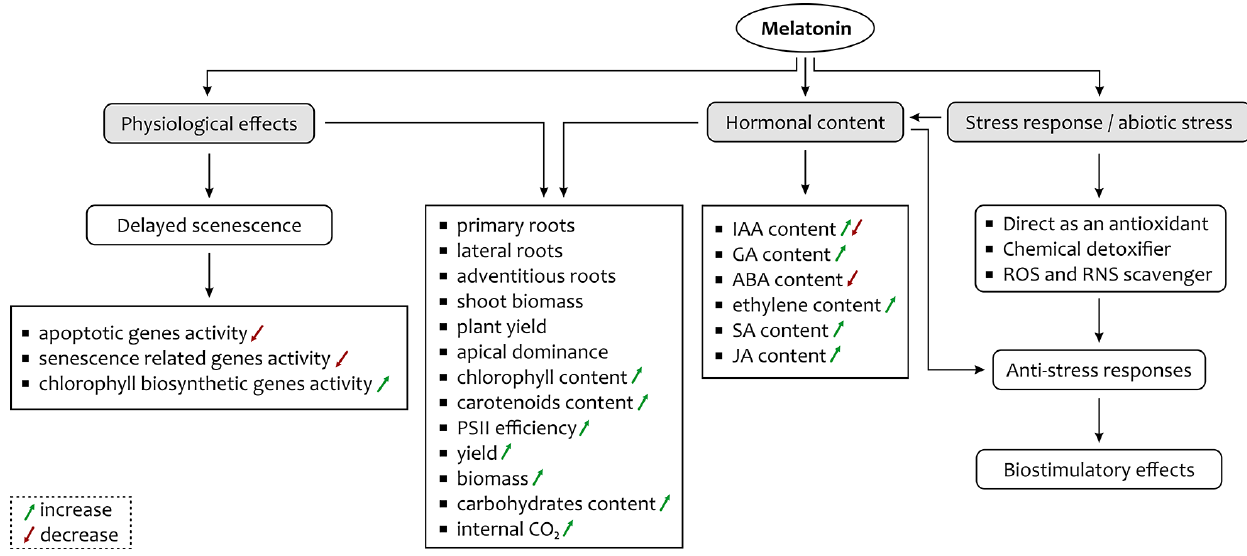
Figure 2 A simplified network of melatonin-mediated responses in plants.